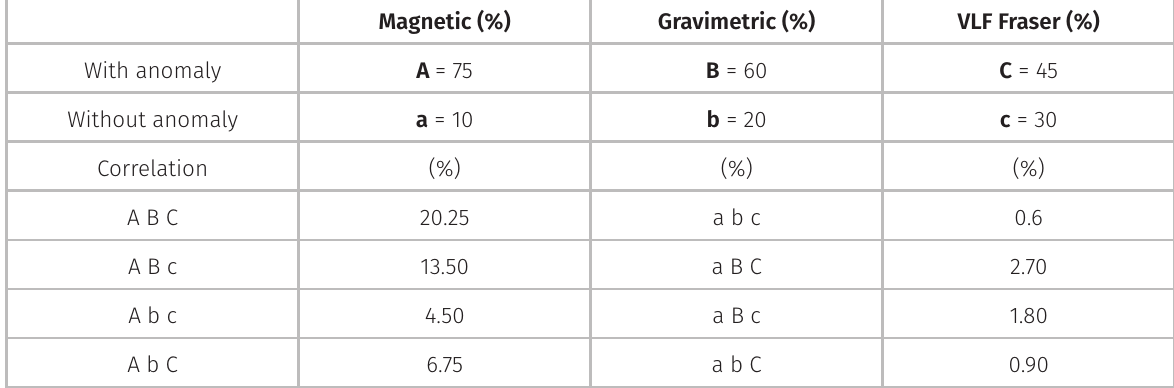
Table I. Correlation of the geophysical anomalies. A: high magnetic peak or trough. a: magnetic background. B: gravimetric peak. b: gravimetric trough or gravimetric background. C: Fraser peak. c: Fraser trough or Fraser background.